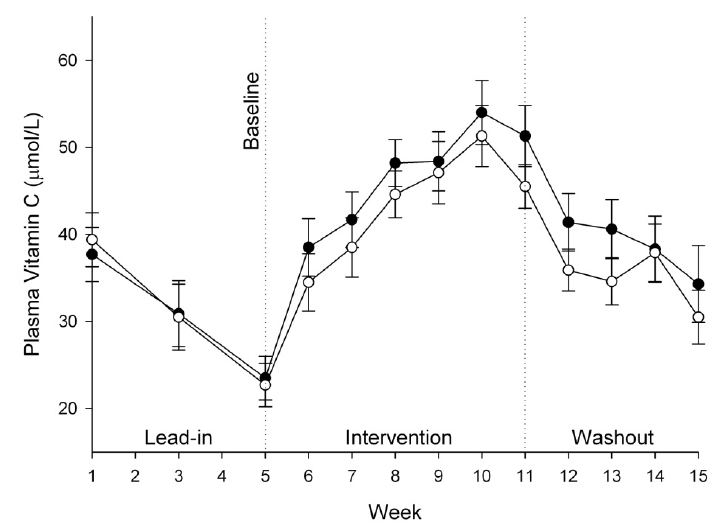
Figure 2. Plasma ascorbate concentrations in vitamin C group (50 mg/day, ● ) and kiwifruit group (0.5/day, ○ ). Data represent mean ± SEM. Two way analysis of variance with